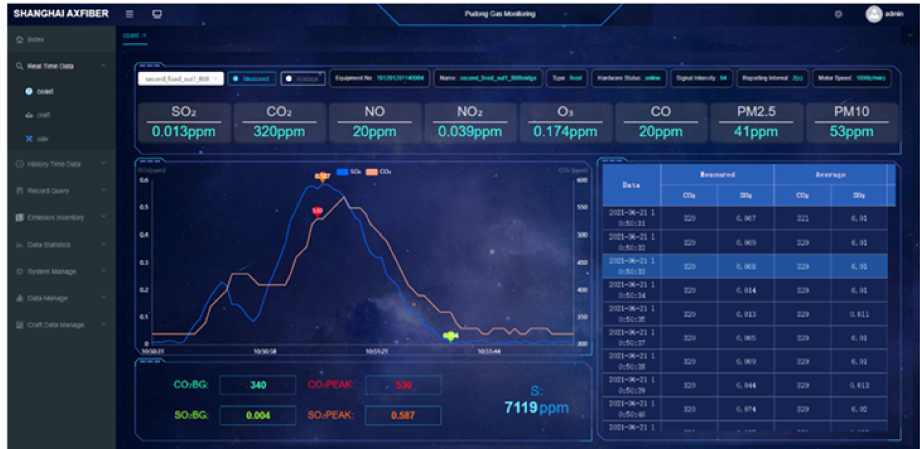
Figure 5. Software user